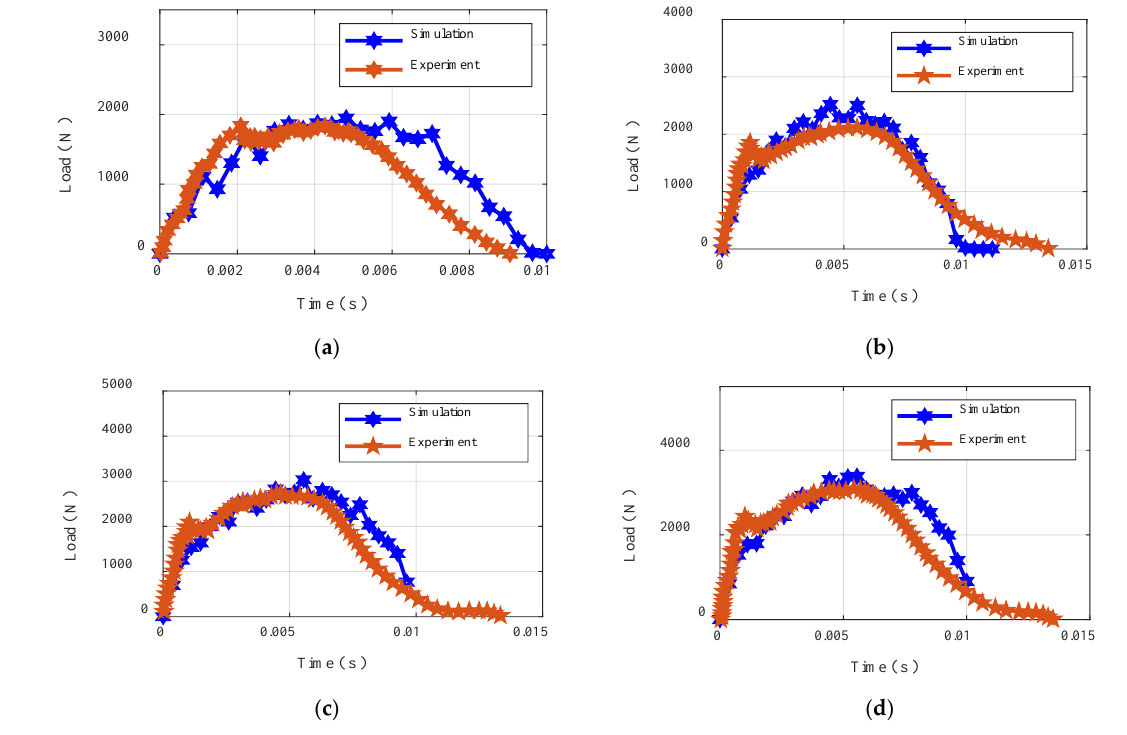
Figure 6. The peak load variation versus time under increasing impact velocities: ( a ) 1.5 m/s, ( b ) 2 m/s, ( c ) 2.5 m/s, and ( d ) 3 m/s.